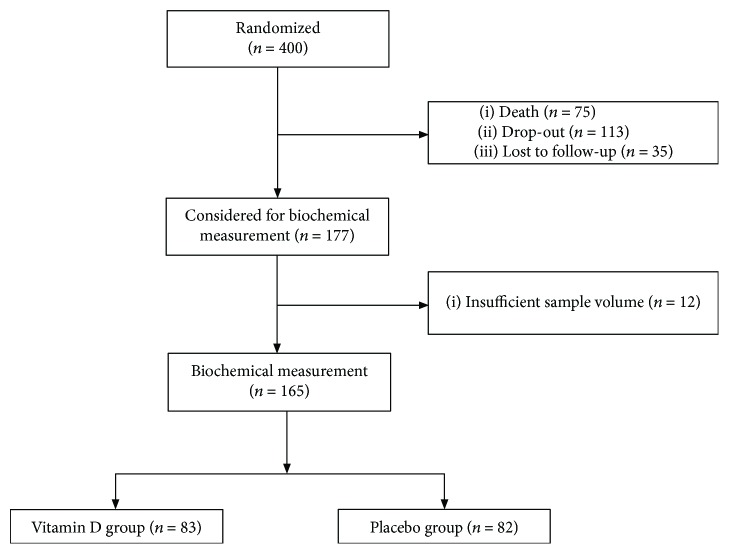
Study flow chart.